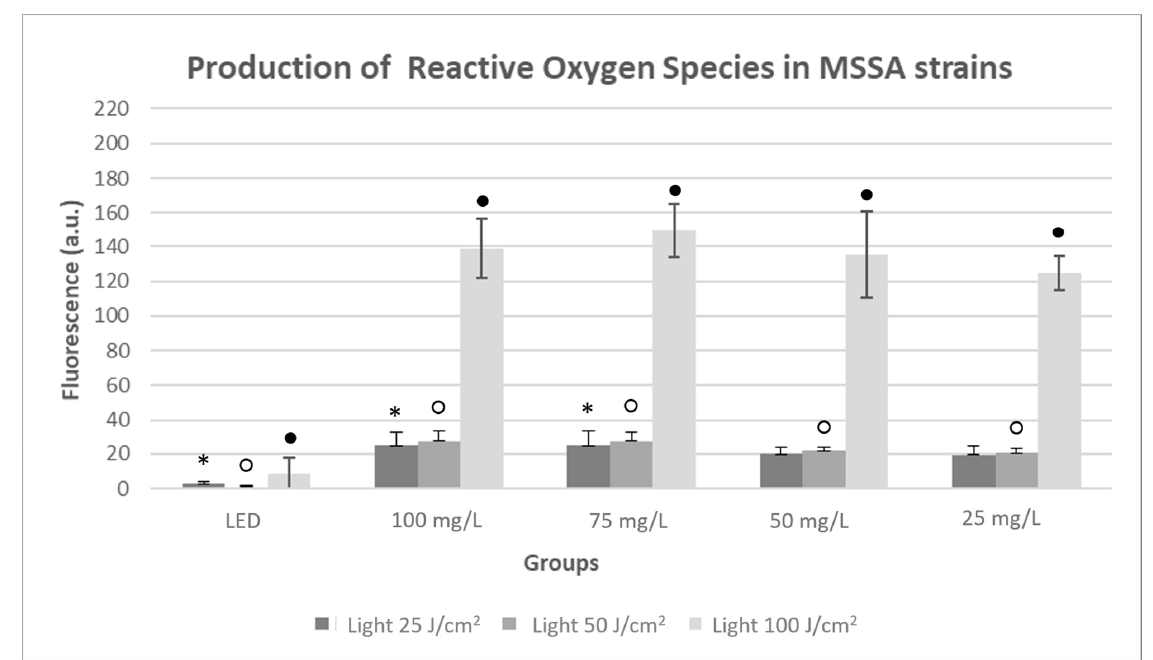
Figure 8. Production of ROS in MSSA strains, presenting a Light control group without PS (LED), Photodithazine ® at 25, 50, 75, and 100 mg/L, all irradiated (Light) at the fluences of 25, 50, and 100 J/cm 2 . * Significant differences were observed between the LED group to 100 and 75 mg/L with light 25 J/cm 2 groups; . ○ Significant differences were observed between the LED group to 100, 75, 50, and 25 mg/L with light 50 J/cm 2 groups; ● Significant differences were observed between the LED group to 100, 75, 50, and 25 mg/L with light 100 J/cm 2 groups.